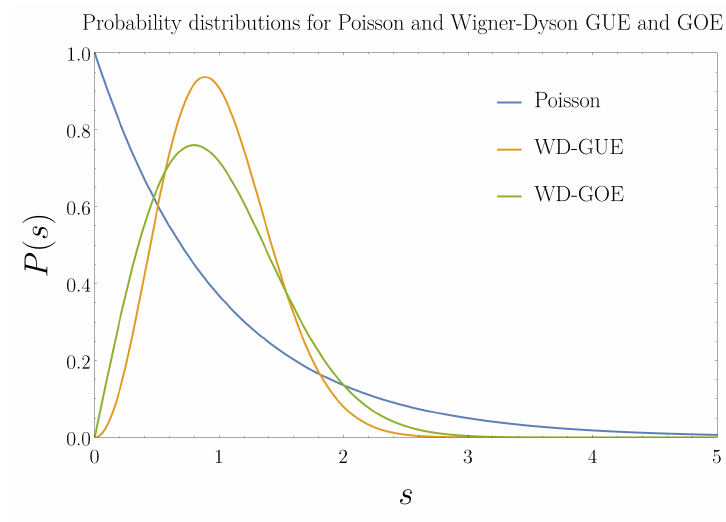
Figure 1: Plot of the nearest level spacing distributions Poisson, Wigner Dyson GUE and GOE reported in Eq.